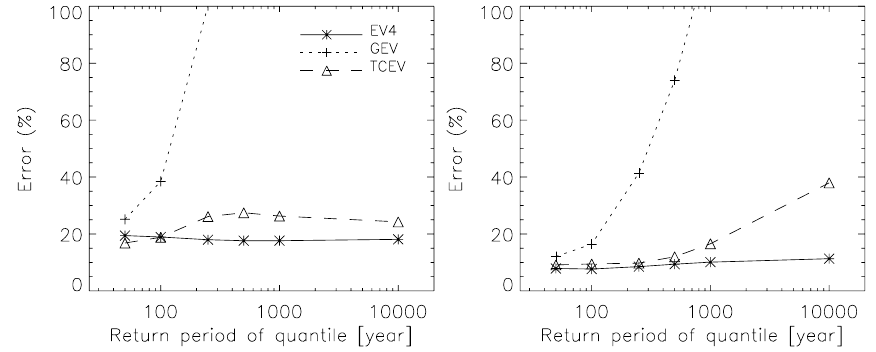
Fig. 6. Estimation error (in %) of ˆ q T for EV4, GEV and TCEV distribution functions, assuming an EV4 population. H = 50, M = 400 and N = 50 years. Left: scenario 1, right: scenario 2.